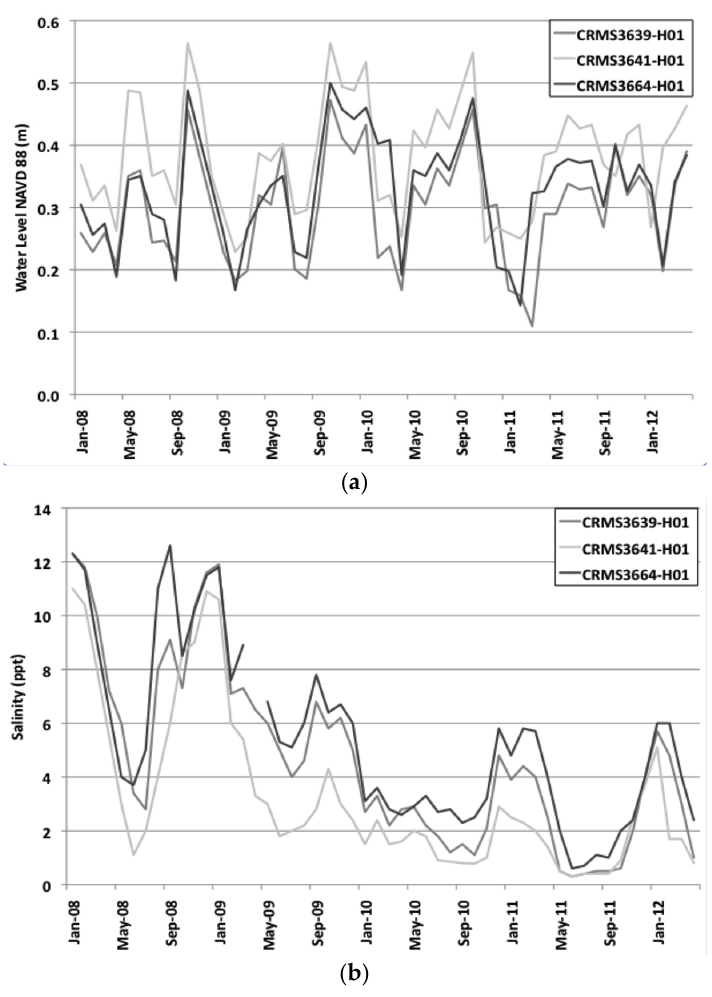
Figure 9. Surface water level (NAVD 88; a ); and surface water salinity ( b ) measured at three Coastwide Reference Monitoring System (CRMS) sites in the CWU. Reference Monitoring System (CRMS) sites in the